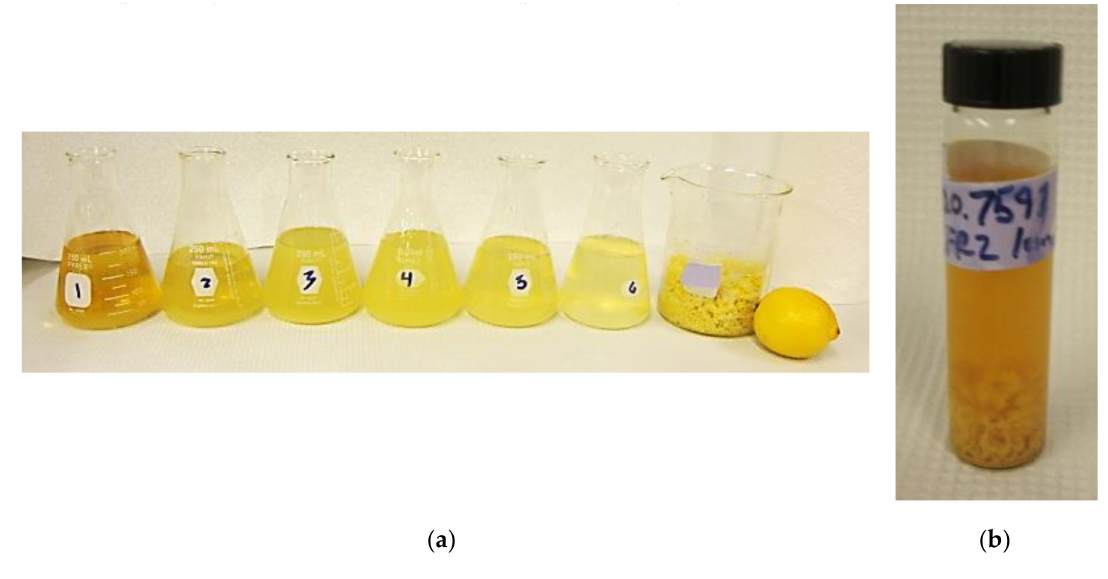
Figure 3. Ground lemon zest extracted three times (1,2,3) with 95:5 H 2 O:EtOH followed by three new extraction rounds (4,5,6) with 50:50 H 2 O:EtOH ( a ). The solid precipitate upon addition of the extracts to pure EtOH ( b ). (Pictures by B. Forest and Professor M.T. Hamann, The Medical University of South